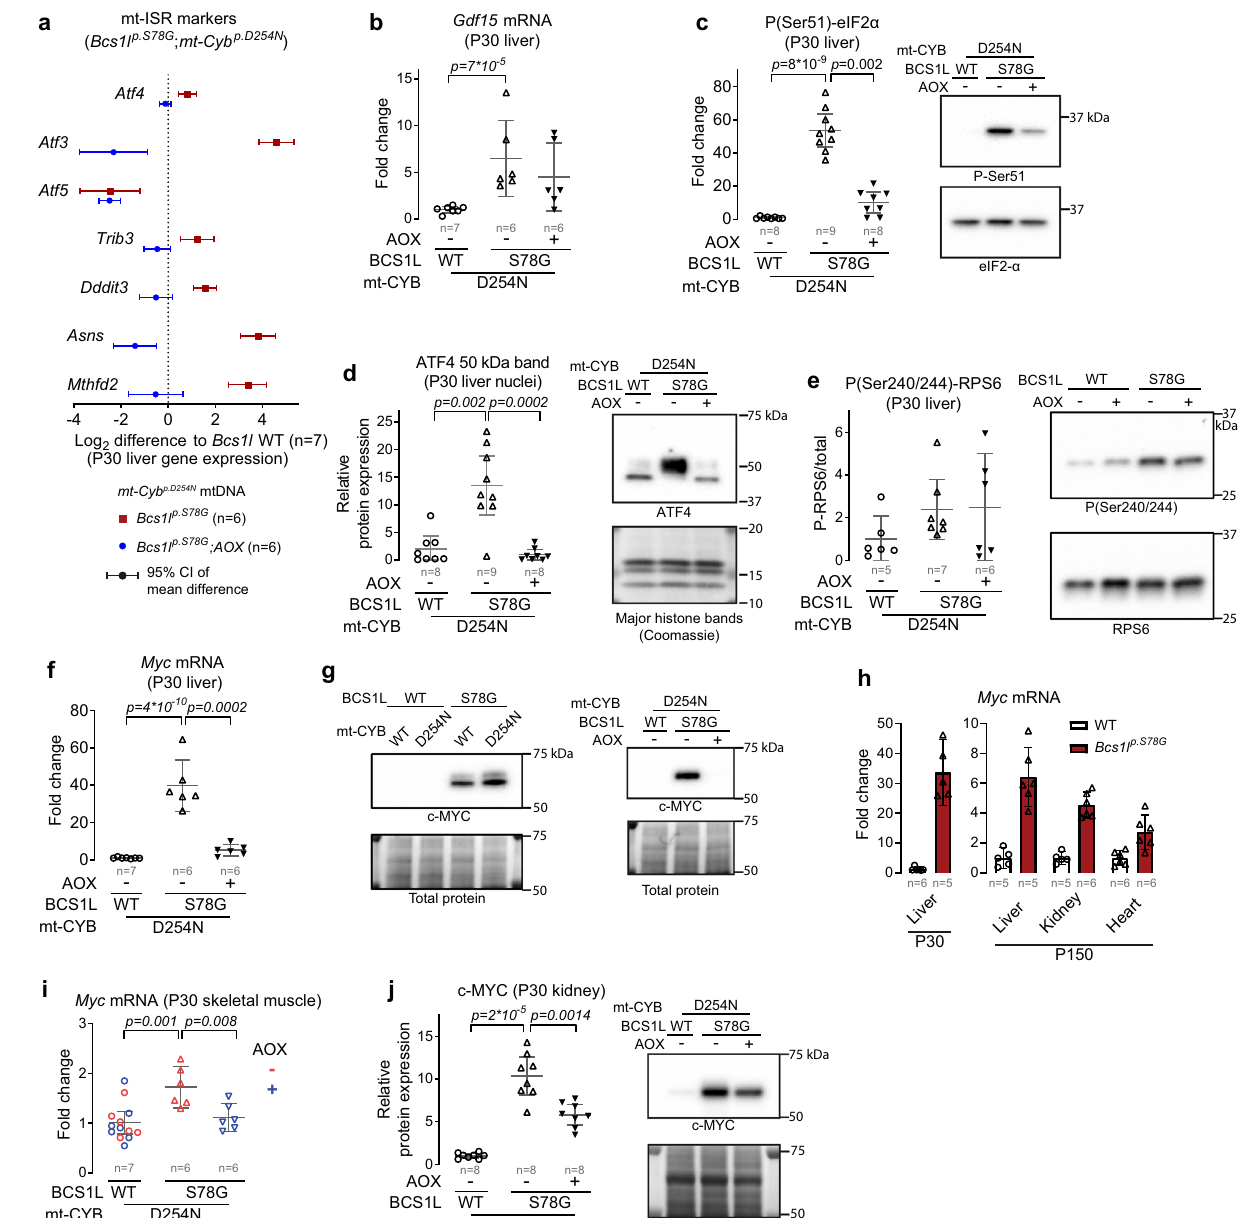
Fig. 7 | AOX supresses mitochondrial integrated stress response (mt-ISR) and c-MYCinduction.a Geneexpressionofmt-ISRmarkersinP30liver. b , Gdf15 mRNA expression in P30 liver. c , d Western blot quanti fi cation of eIF2- α phosphorylation andATF4expressionasreadoutsofmt-ISRactivation.ATF4wasdetectedfromliver nuclear fractions. e Westernblotassessment of mTORC1 activationbased on RPS6 phosphorylation status. f Myc mRNA expression (qPCR) in P30 liver from mice of mt-Cyb p.D254N background. g c-MYCproteinexpressioninP30liverfrommiceofthe